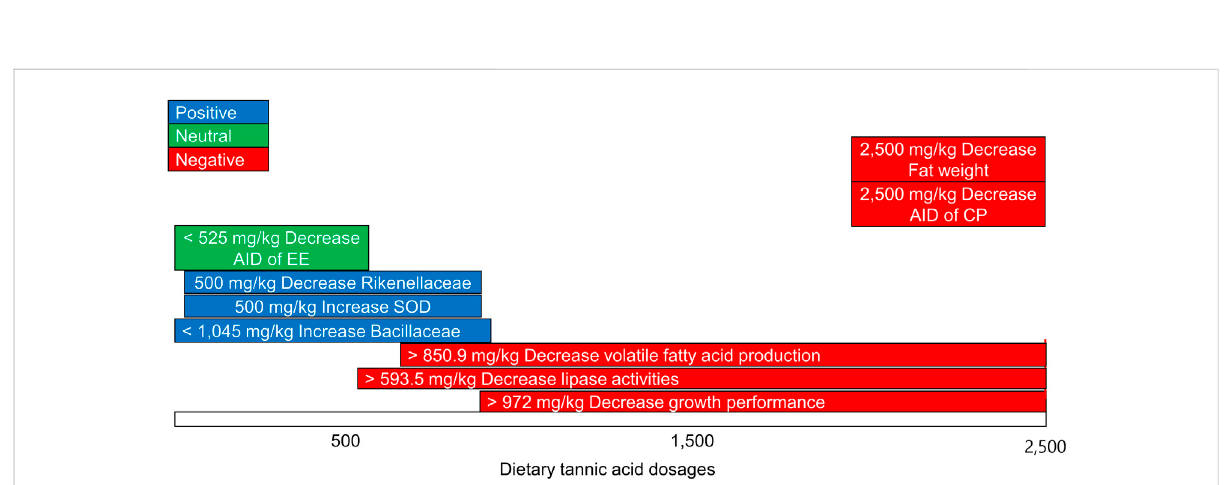
FIGURE 16 Summary of different effects of diverse doses of dietary tannic acid in broilers. SOD, superoxide dismutase; AID, apparent ileal digestibility, EE, ether extracts; CP, crude